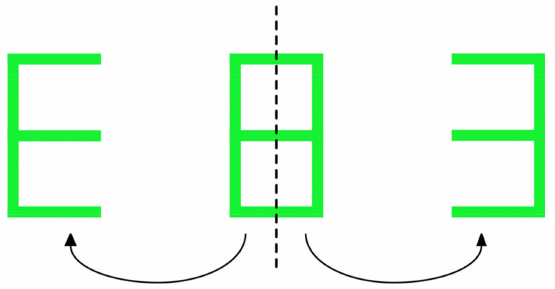
Figure 1. An example of misrecognition with incomplete